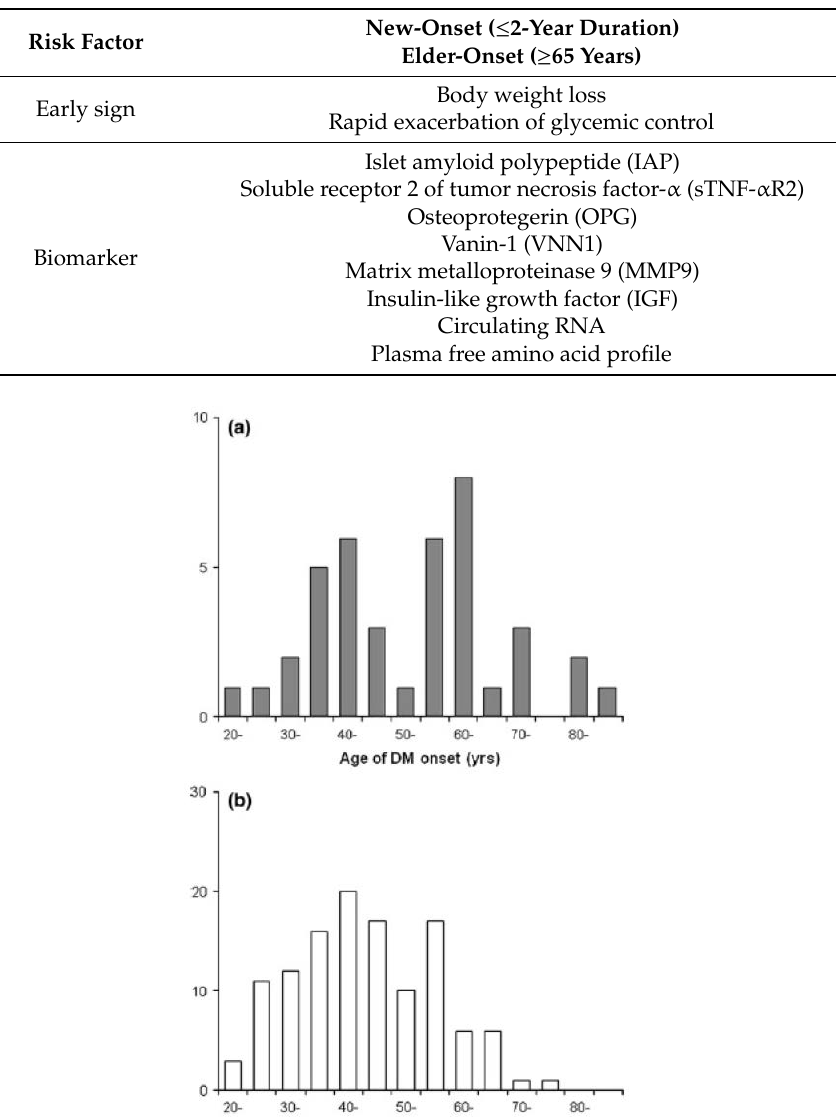
Table 1. Risk factors, early signs, and biomarkers for pancreatic cancer in patients with diabetes mellitus.